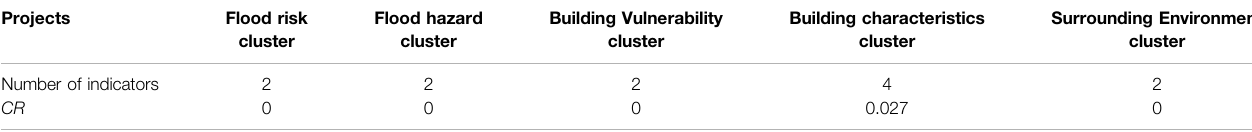
TABLE 5 | Inconsistences index result of the AHP.